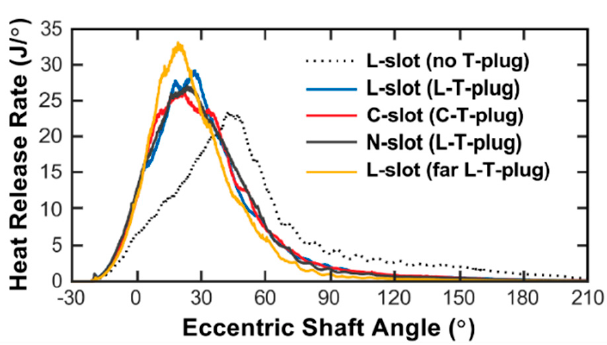
Figure 12. Simulated HRR for different configurations of a slot and T-plug.